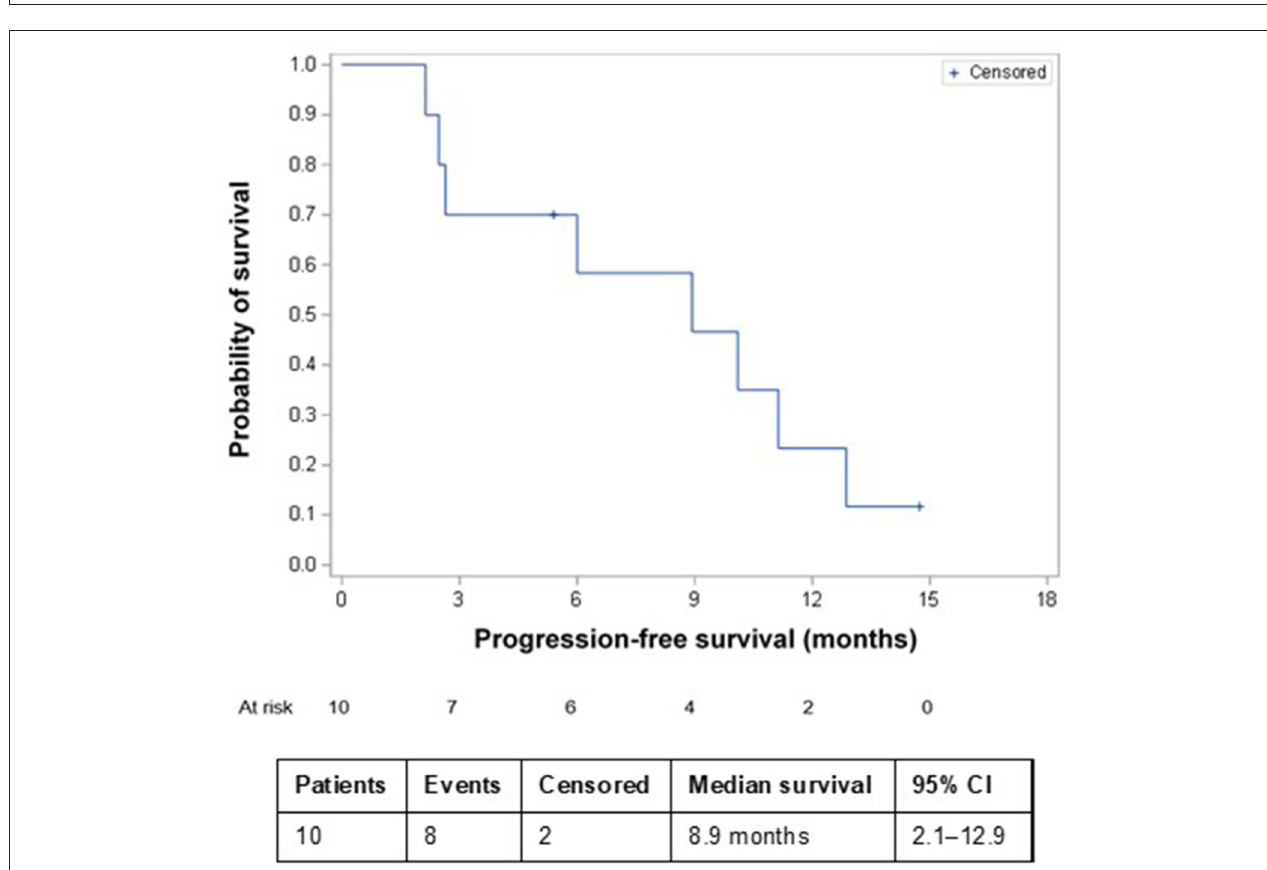
FIGURE 3 | Kaplan–Meier progression-free survival in patients receiving TTFields + RT + TMZ and TTFields + TMZ maintenance therapy. CI, confidence interval; RT, radiation therapy; TMZ, temozolomide; TTFields, Tumor Treating Fields. progression with no effect on OS (20). Anti-angiogenic therapies with TMZ is one such strategy. A meta-analysis compiling 6 randomized controlled trials combining BEV with TMZ for such as BEV may further increase the risk of skin-related ndGBM indicated a 33% reduction in the risk of disease AEs associated with TTFields (21). Concurrent therapies for